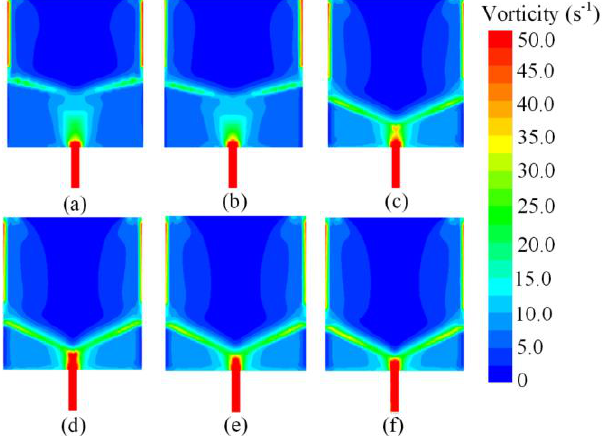
Figure 3. Vorticity cloud profiles of the multiphase vortex. ( a ) t = 15.0 s, ( b ) t = 18.5 s, ( c ) t = 38.0 s, ( d ) t = 43.5 s, ( e ) t = 46.50 s, ( f ) t = 53.0 s.